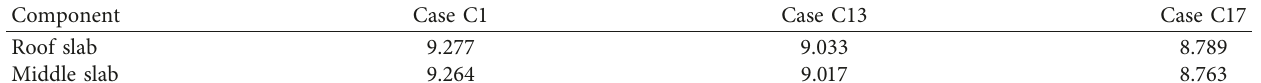
Figure 15: Peak accelerations of the subway station structure under the Kobe ground motion. Table 5: Natural frequency of the model structure in different cases (unit: Hz).